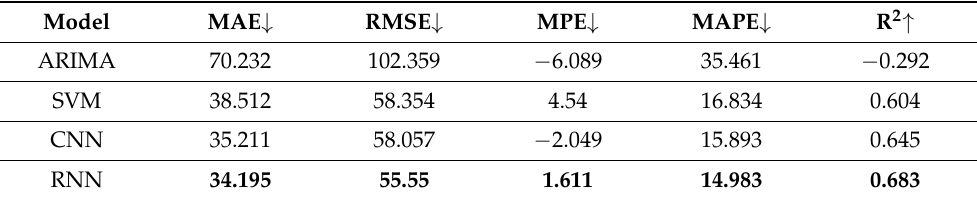
Figure 4. The prediction performances of four prediction models. Table 1. Different prediction indicators of four prediction models.